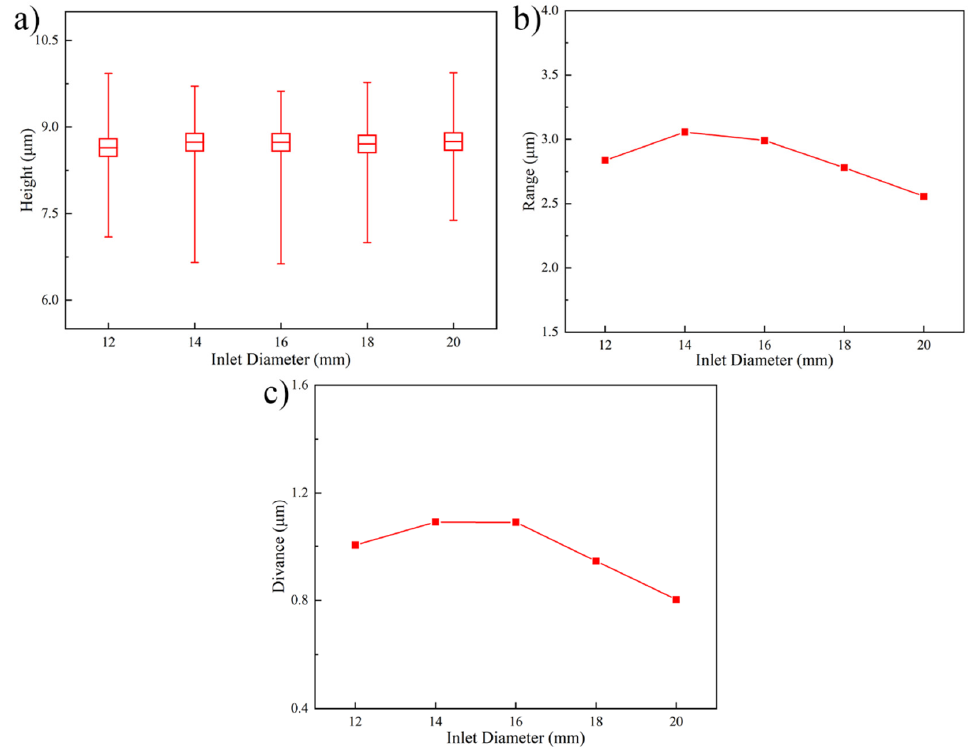
Figure 5. Au bump height and uniformity under different inlet diameters. ( a ) Au bump height, ( b ) Au bump range, and ( c ) Au bump deviance.